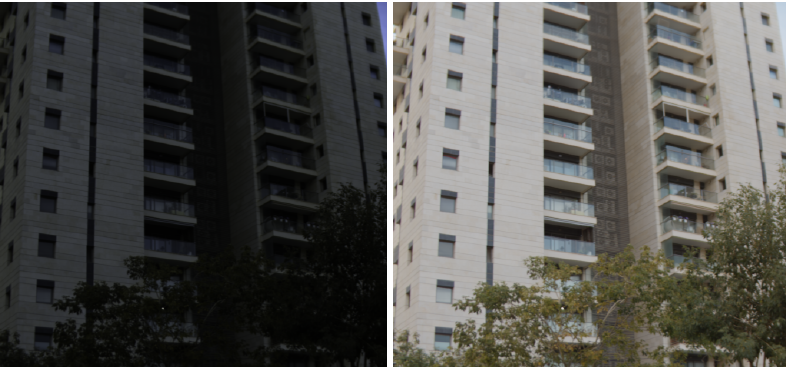
Figure 2. Comparison of the LDR-RGB and the created pseudo-HDR-RGB image. The left image is LDR-RGB, and the right is